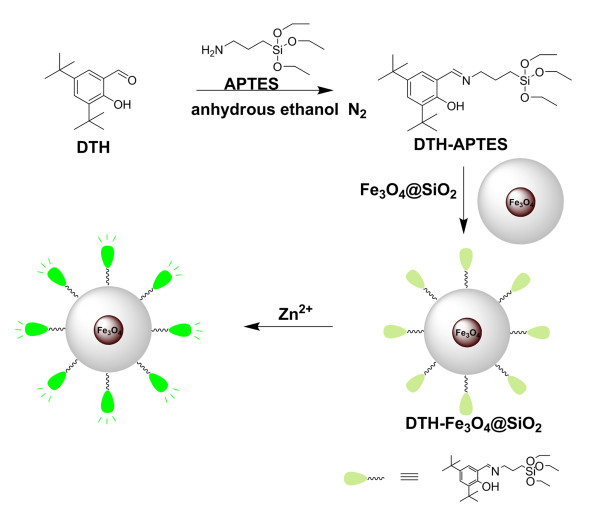
Syntheses of DTH-APTES and DTH-Fe3O4@SiO2.